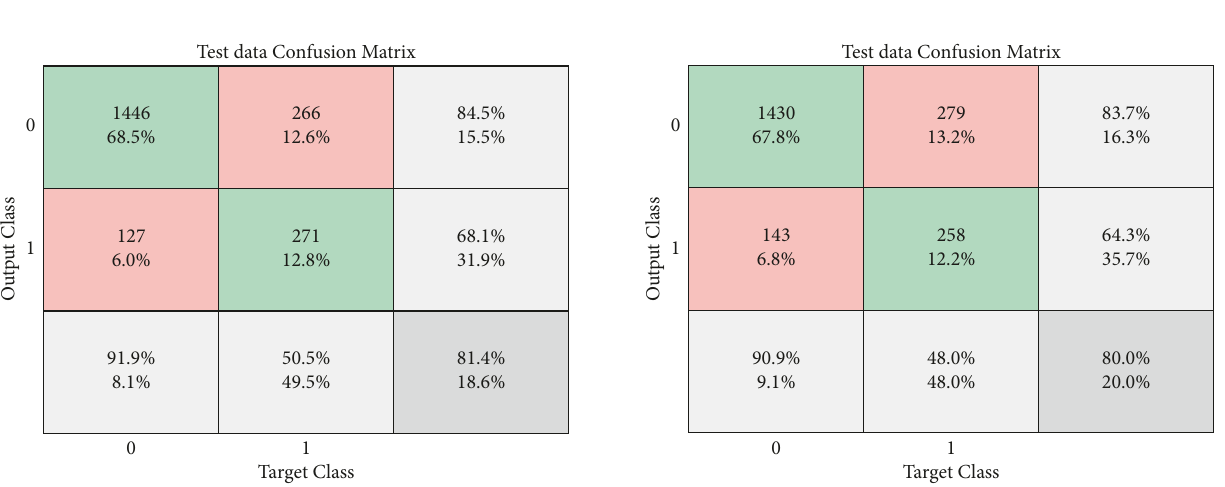
Figure 10: Confusion matrix resulting from the worst performance of the proposed system in 10 runs.